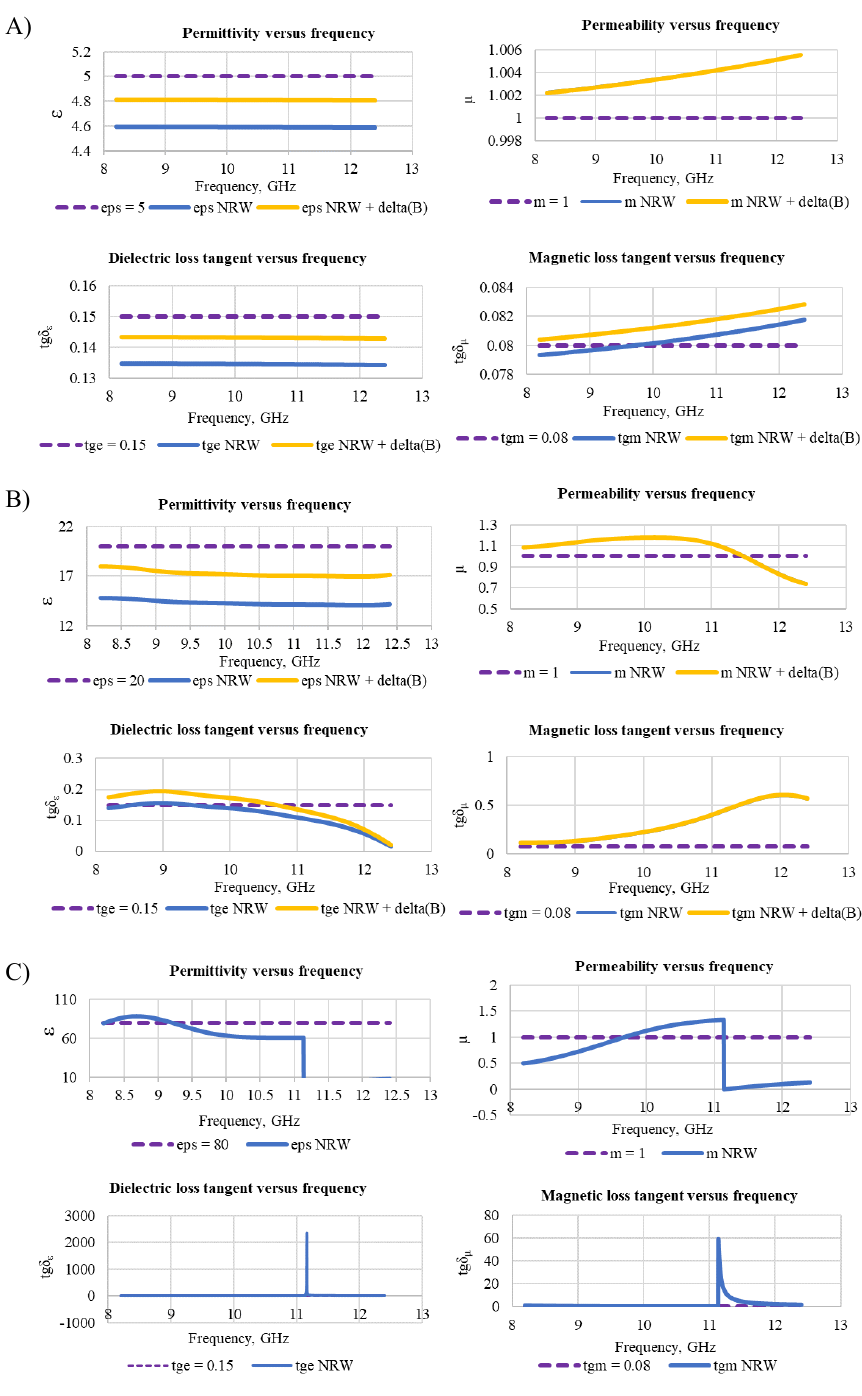
Fig. 1. Dielectric and magnetic characteristics, calculated with corrected and non-corrected NRW algorithm for three reference material samples with the length of 3mm,the gap of 161 um, μ = 1, tgδ ε = 0.15, tgδ μ = 0.08 and ε = 5 (А), ε = 20 (B), ε = 80